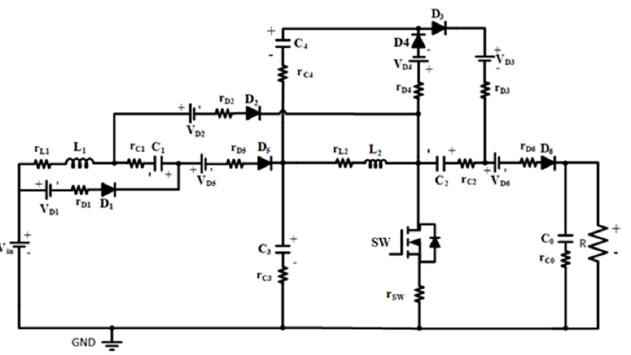
Figure 10. Equivalent circuit diagram of the studied converter with parasitic elements in each com- ponent.